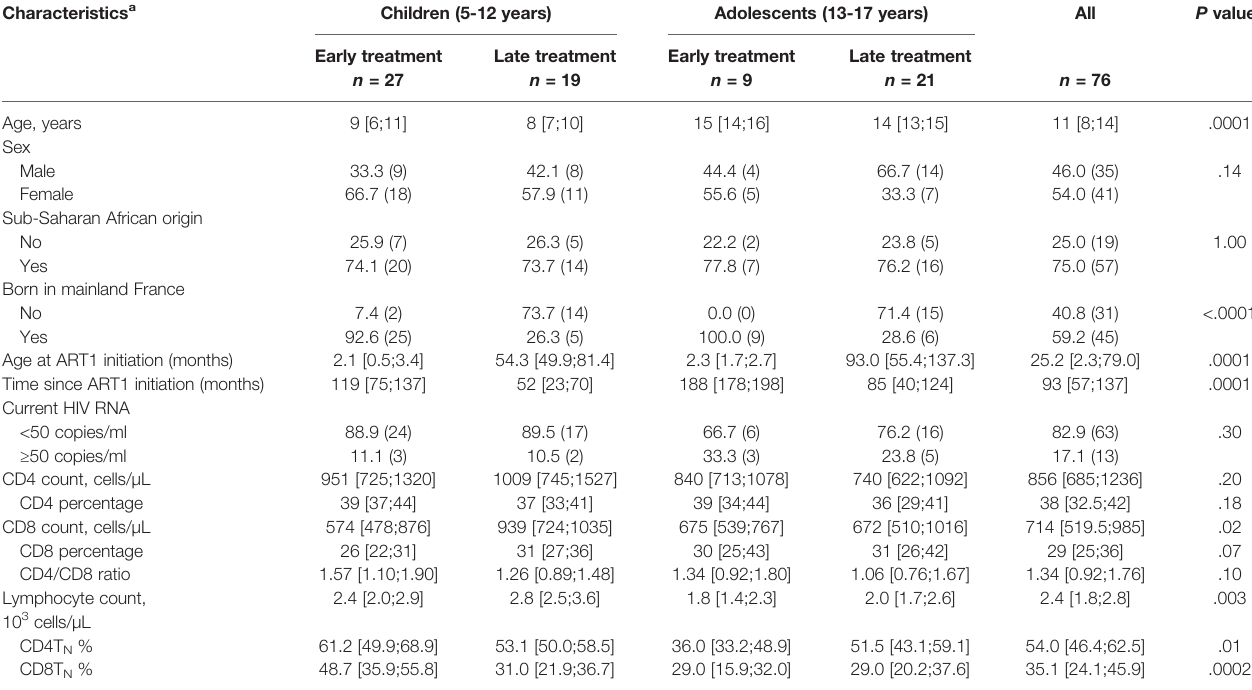
TABLE 1 | Patient ’ s